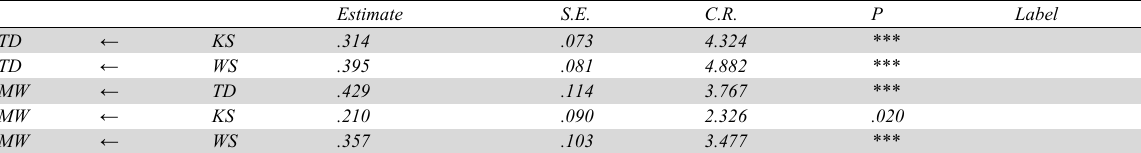
Hypothesis 1-5 Test Results